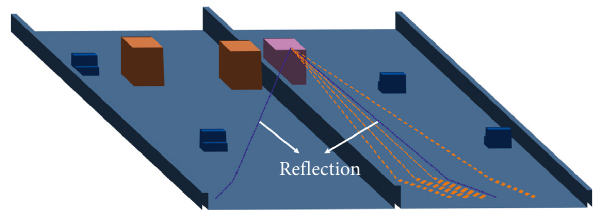
Figure 13: NLOS channel with the strong reflected path.